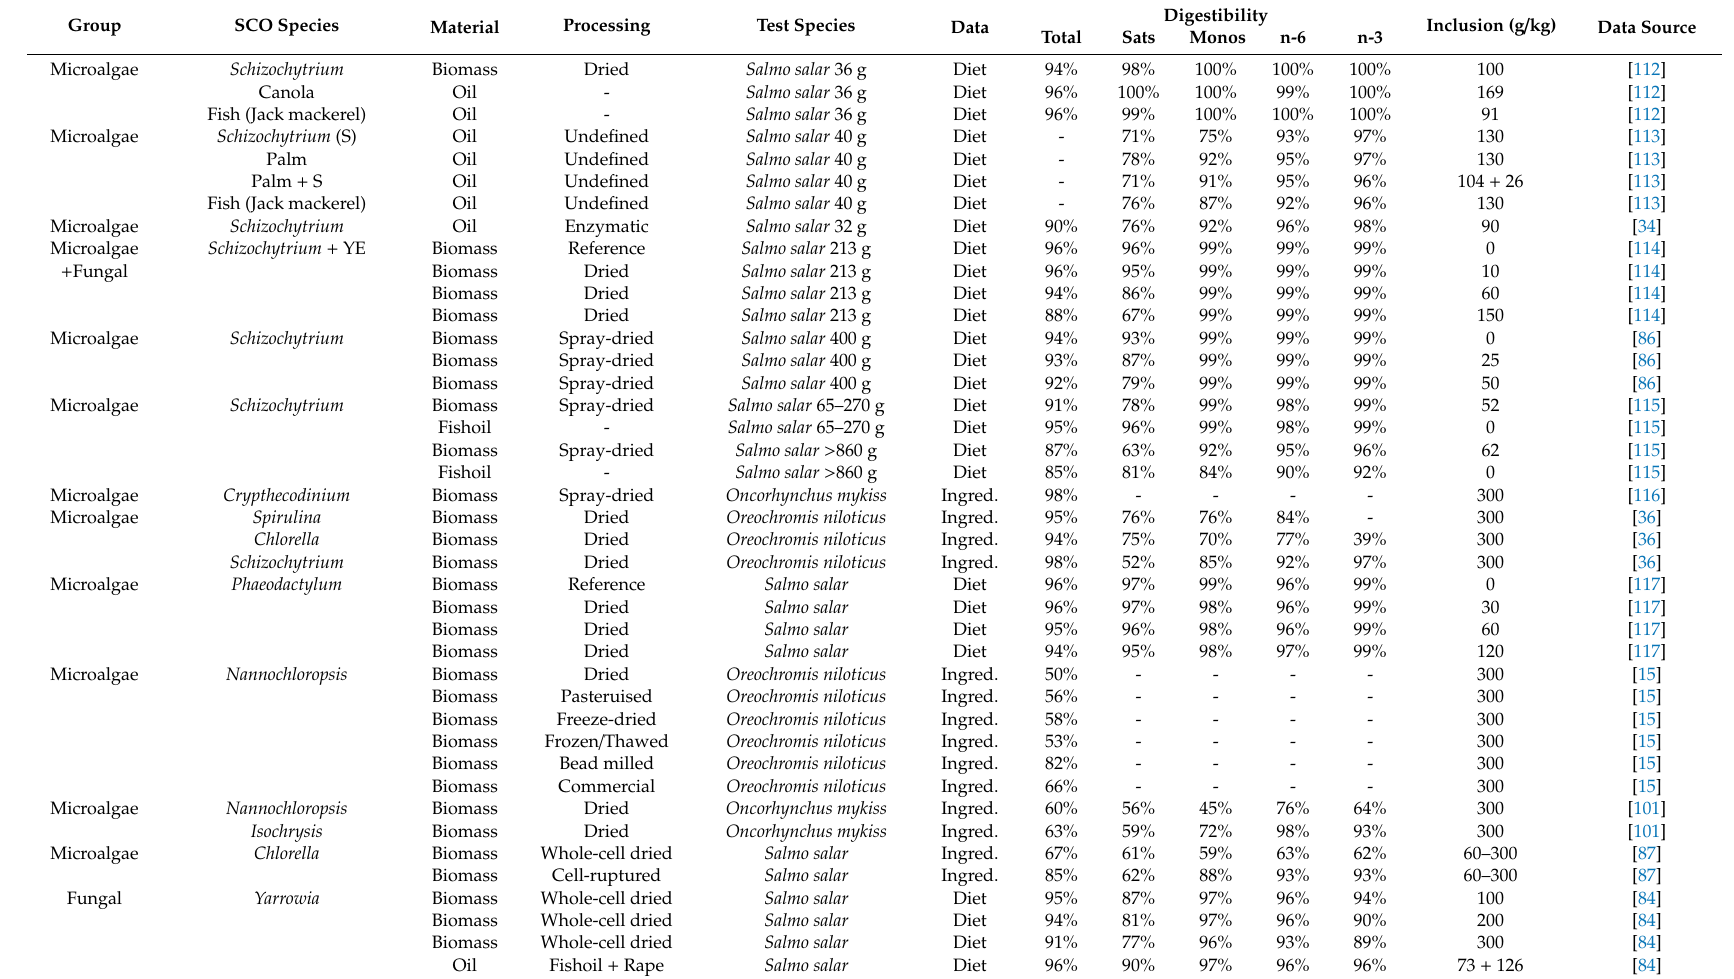
Table 5. Influence of material and processing on lipid and fatty acid class digestibility of various SCO